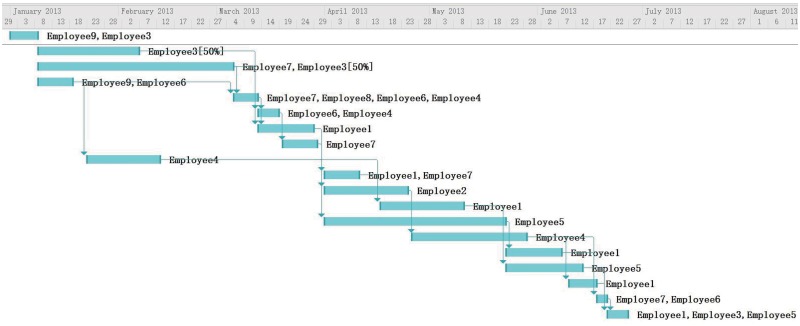
Scheduling Result from Expert 2.